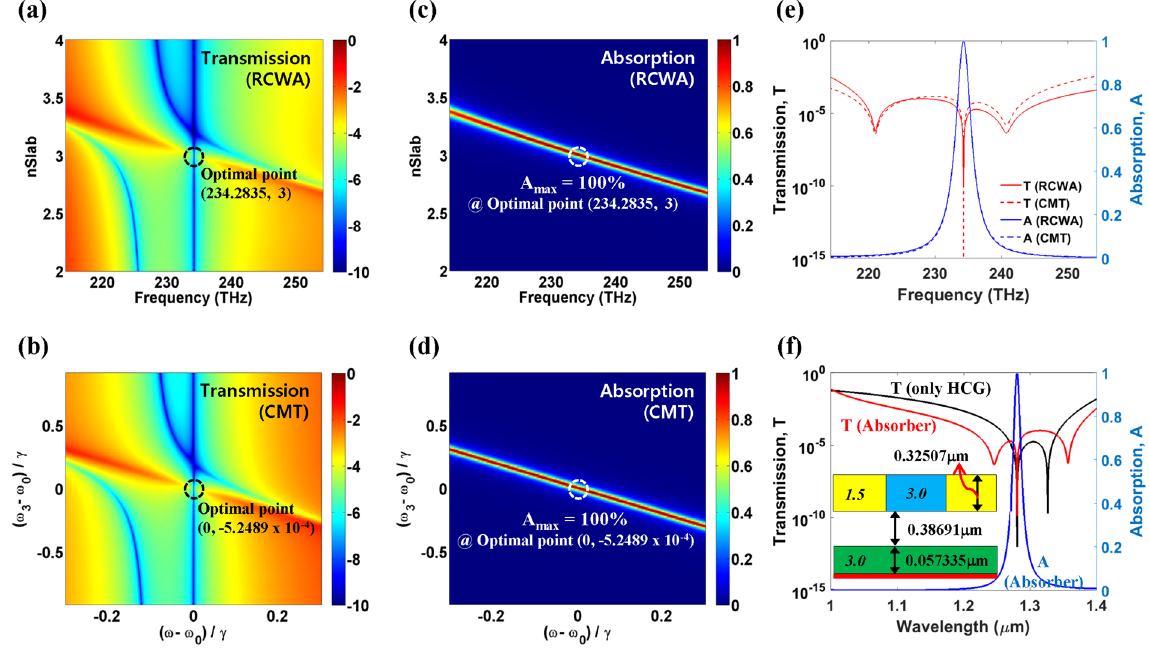
Figure 2. Transmission spectra calculated using ( a ) RCWA and ( b ) CMT for the proposed “ triple - mode absorber ” with d Grat = 0.32507 μ m, d Gap = 0.38691 μ m, and d Slab = 0.057335 μ m. Both are plotted on the same logarithmic color scale. Absorption spectra calculated using ( c ) RCWA and ( d ) CMT for the same conditions. In all plots, the optimal (perfect absorption) points are also denoted by the dashed circle. ( e ) Comparison of RCWA and CMT results for each optimal condition; that is, n Slab = 3 and ( ω 3 − ω 0 )/ γ = − 5.2489 × 10 − 4 . ( f ) Comparison of RCWA results for the optimal “ triple - mode absorber ” ( n Slab = 3) and a lossless HCG alone (the inset indicates the schematic of the designed perfect “ triple - mode absorber